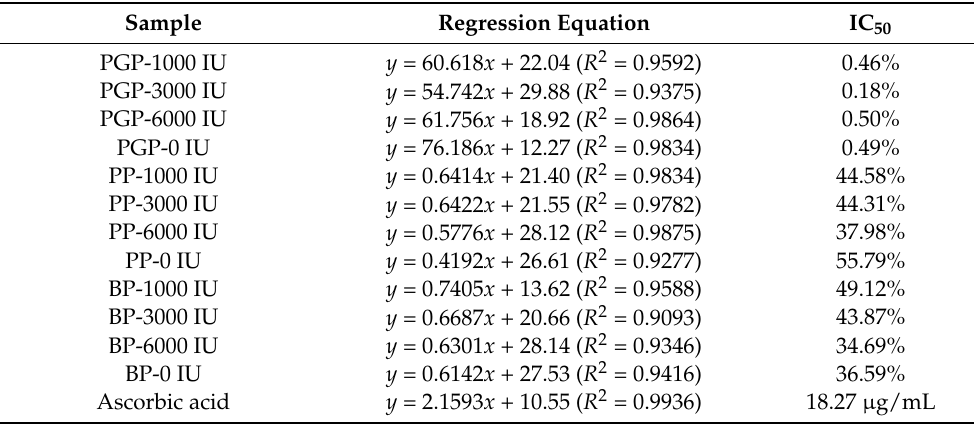
Table 9. IC 50 values of fermented fruit peel extracts and ascorbic acid.